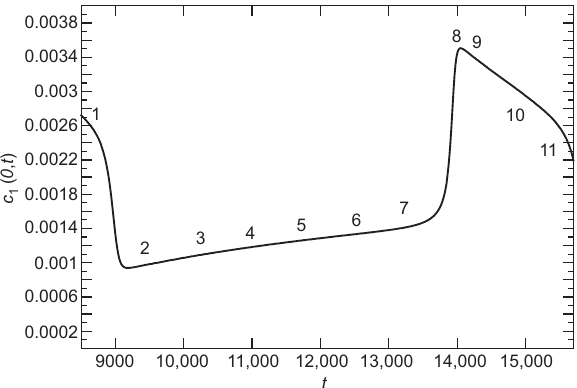
Figure 7 Zoom on a period of oscillation of c sequence of times as in Figure 5.